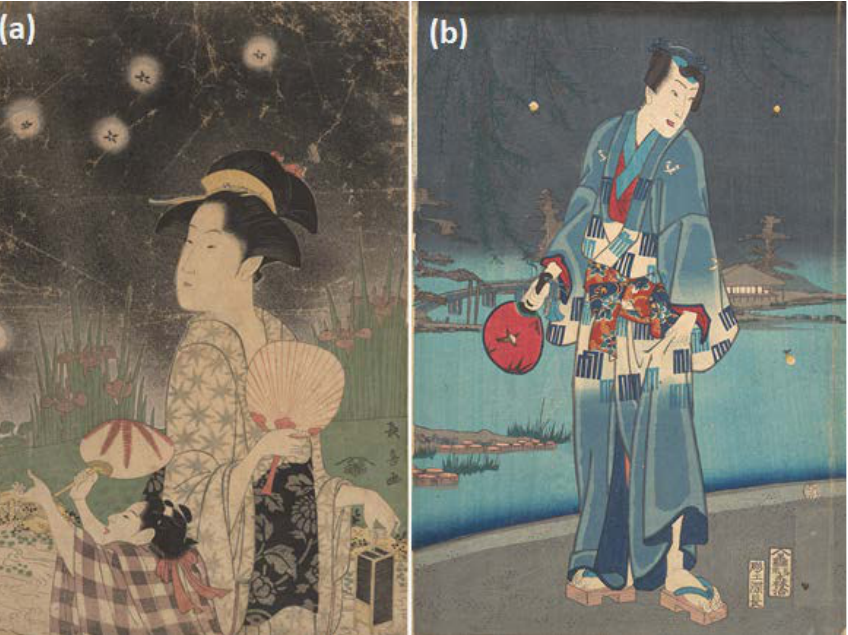
Figure 3. The Metropolian Museum of Art, New York, USA, www.metmuseum.org (accessed on 4 January 2022). Open access images, CC0. ( a ) (T16). Woman and Child Catching Fireflies. ca.